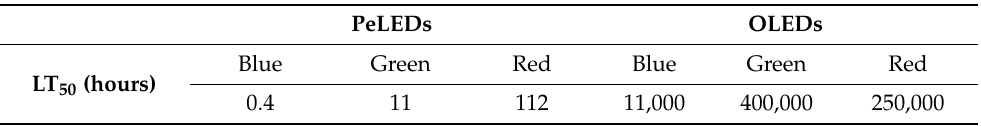
Table 3. Lifetime comparison of PeLEDs and OLEDs Reprinted with permission from Ref. [56]. 2021, Springer Nature. PeLEDs OLEDs Blue Green Red Blue Green Red LT 50 (hours) 0.4 11 112 11,000 400,000